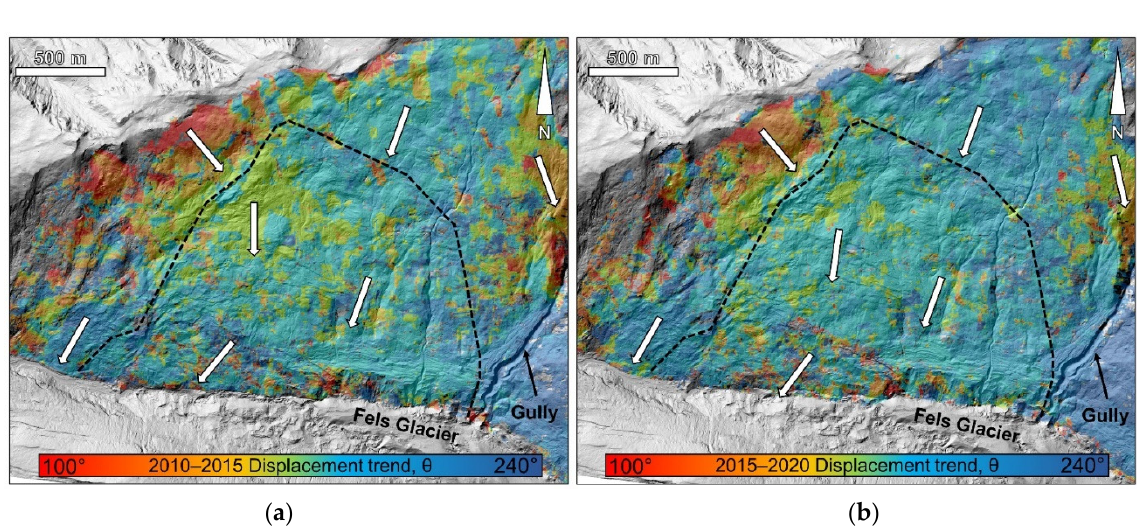
Figure 6. Displacement trend maps of the Fels landslide overlain on the 2016 ALS hillshade base map. ( a ) Displacement trend map computed for the 2010–2015 time window. ( b ) Displacement trend map computed for the 2015–2020 time window. Note the overall S to SSW displacement direction across the landslide body, outlined by the black dashed line and the SE-trending deformation fields along the W boundary of the landslide area and near the gully to the east.